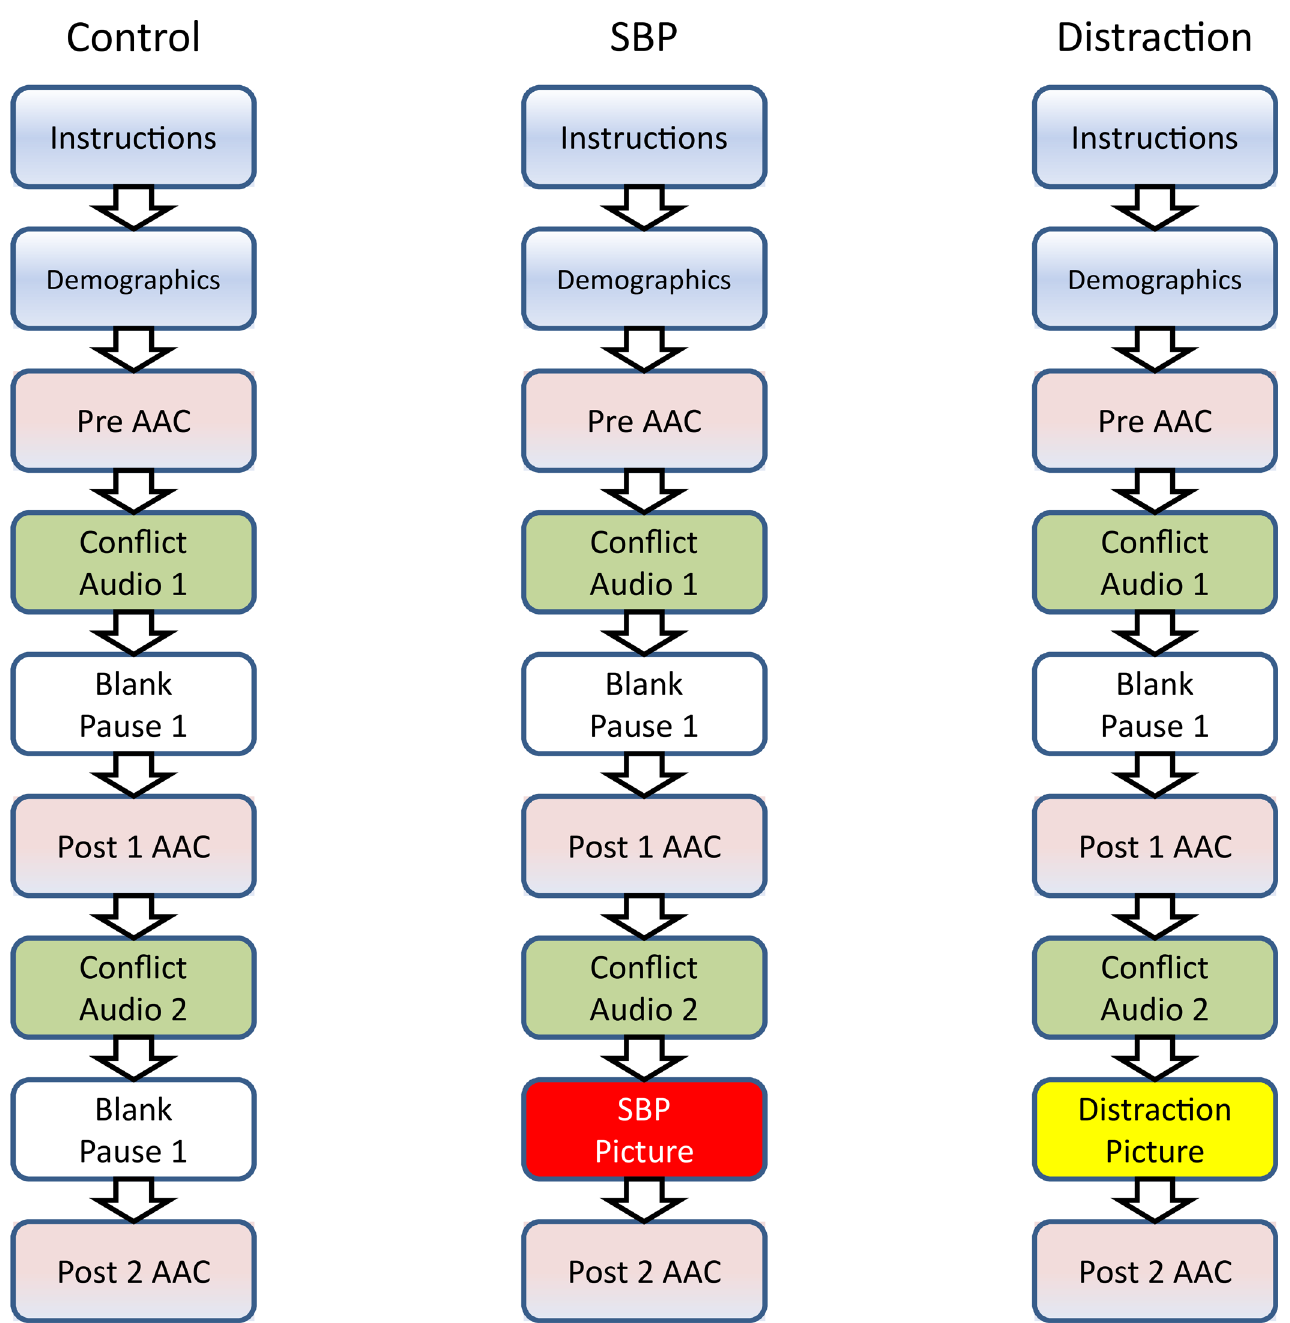
Fig 1. Experimental design and procedural sequence of the original three experimental study groups. Control, SBP (Secure Base Prime), and distraction experiments. Experimental differences between the groups occur after Conflict Audio 2 as indicated by the red (SBP picture) and yellow boxes (distraction picture). AAC = Affective Adjective Checklist (Modified: 16